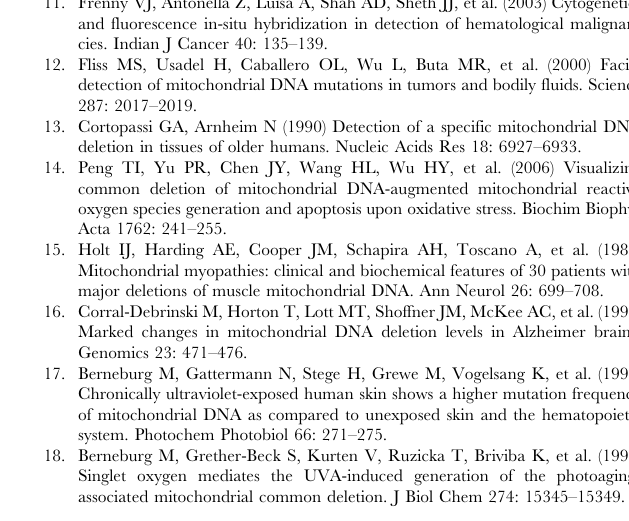
Figure S1 Sensitivity analysis of studies. (A) case/adjacent normal group. (B) case/healthy normal group. Figure S2 Funnel plot analysis to detect publication bias. (A) case/adjacent normal group. (B) case/healthy normal